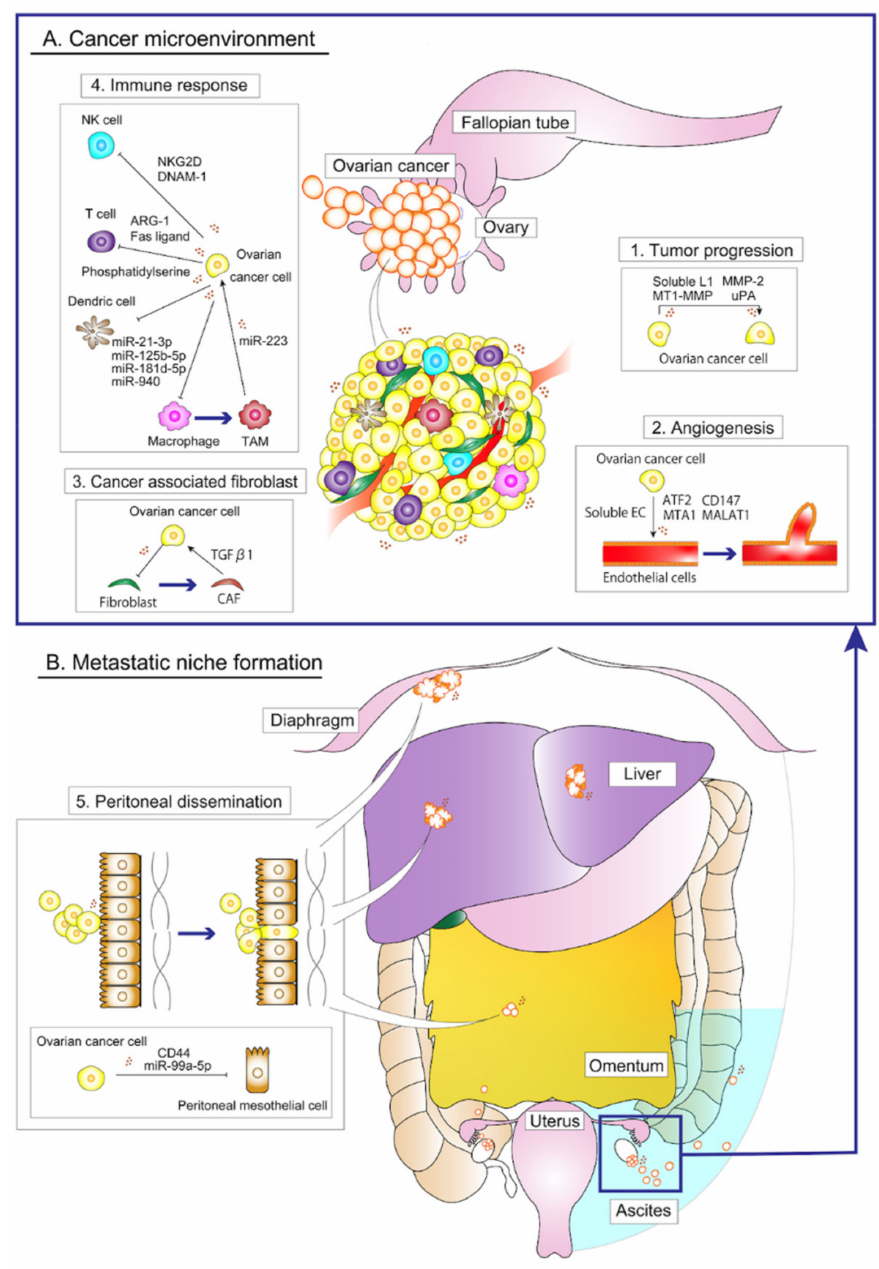
Figure 1. Overview of the roles of ovarian cancer-derived exosomes during local progression and peritoneal dissemination. ( A ) The relationship between cancer-derived exosomes and the cancer microenvironment is summarized. (1) Ovarian cancer cell-derived exosomes and those isolated from ascites promote the progression of ovarian cancer cells [35,36]. (2) Ovarian cancer cell-derived exosomes loaded biomolecules, such as ATF2, MTA1, CD147 and MALAT1, are transferred into endothelial cells where they induce angiogenesis [31–33,50]. (3) Ovarian cancer cell-derived exosomes convert fibroblasts into cancer associated fibroblasts (CAFs). Thereafter, CAF-derived exosomes promote epithelial-mesenchymal transition to ovarian cancer cells [48,49]. (4) Ovarian cancer cell-derived exosomes inhibit immune cells and facilitates the conversion of macrophages to tumor-associated macrophages [38,40–42,44,45]. ( B ) The involvement of exosomes in peritoneal dissemination. (5) Ovarian cancer-derived exosomes induce apoptosis of peritoneal mesenchymal cells and enhance the infiltration of ovarian cancer, thereby promoting the formation of the metastatic niche [21,45,46]. “ → ” thin arrows mean stimulating e ff ects and “T” symbols mean suppressive e ff